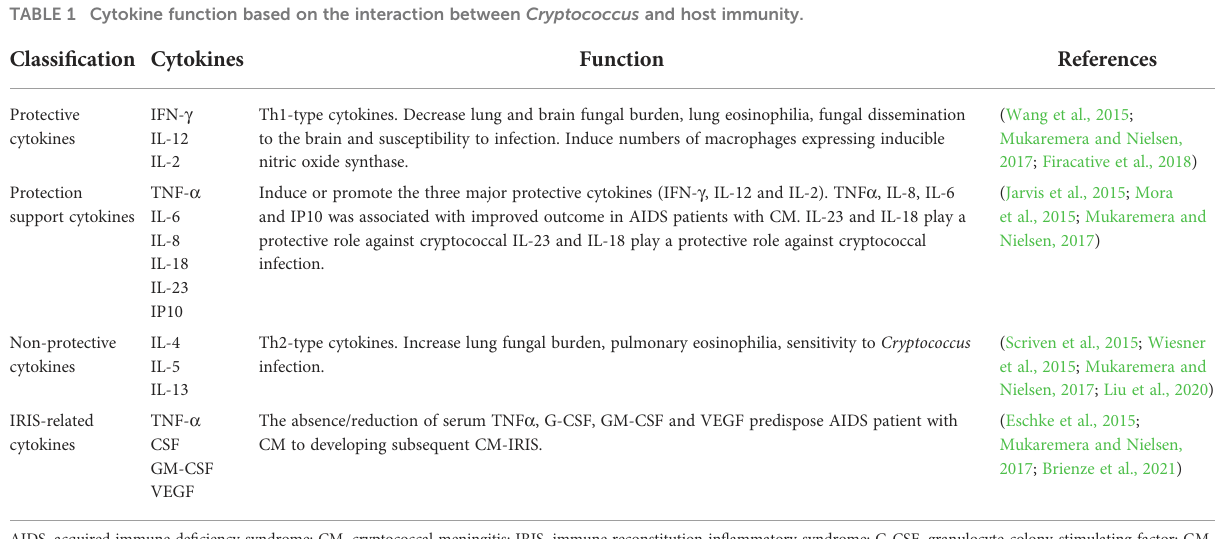
TABLE 1 Cytokine function based on the interaction between Cryptococcus and host